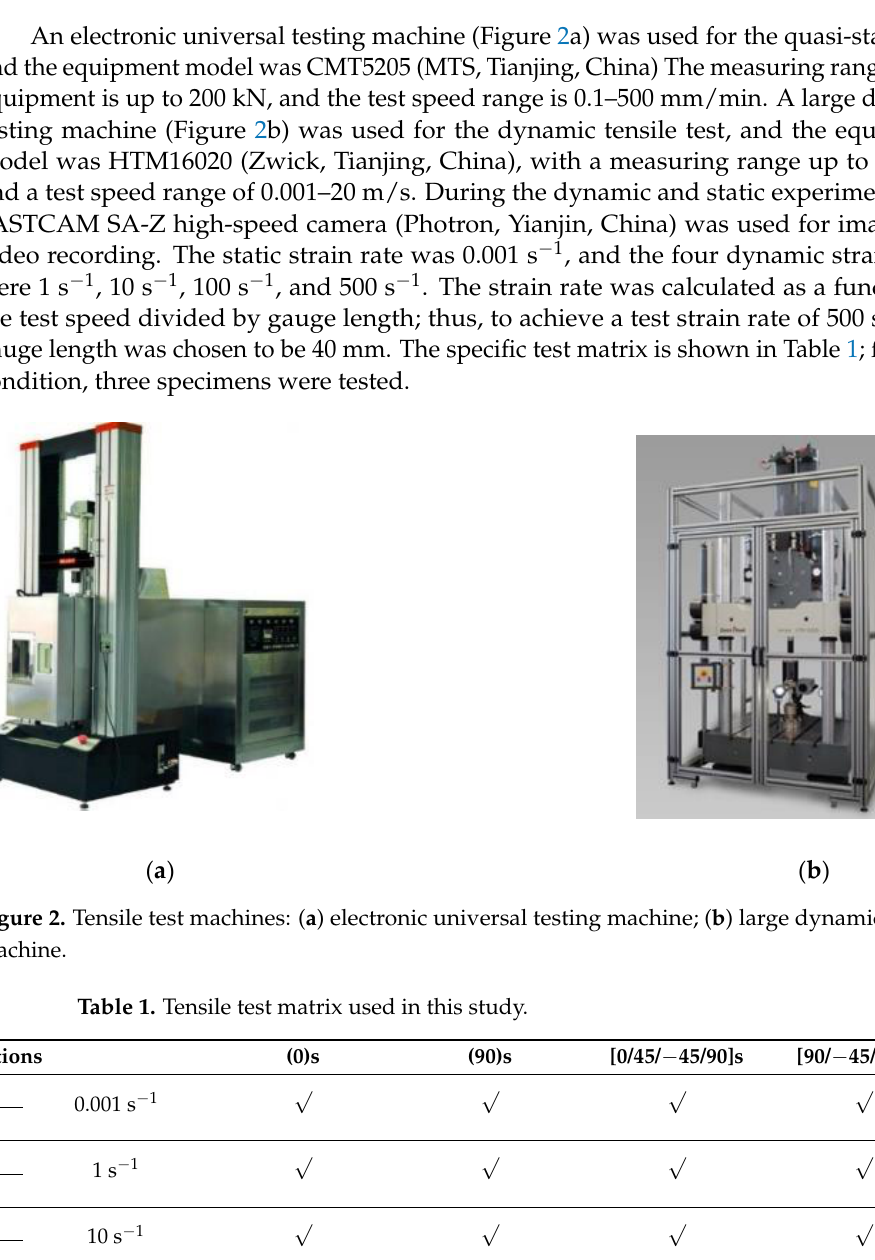
Figure 1. Specimen geometry in mm: ( a ) quasi-static test specimen; ( b ) dynamic test specimen.